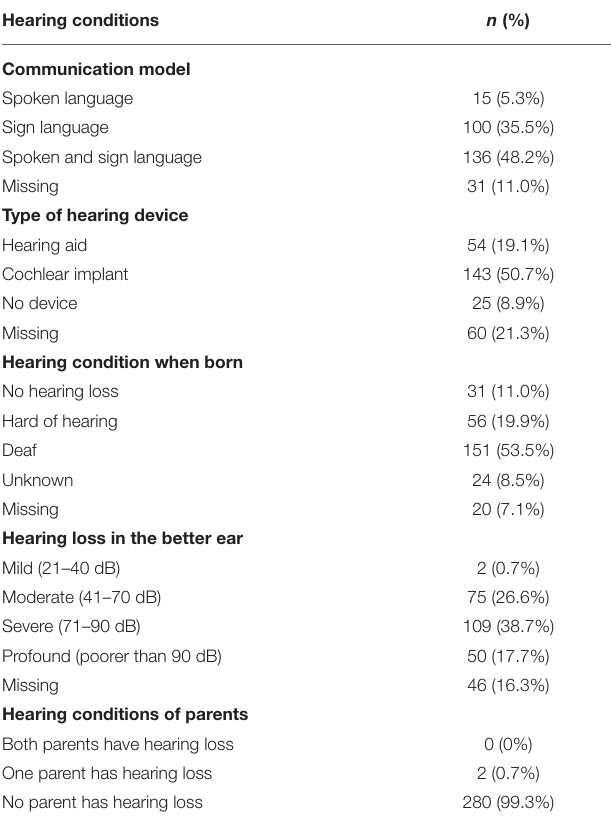
TABLE 1 | Hearing conditions of youths with hearing loss ( N =